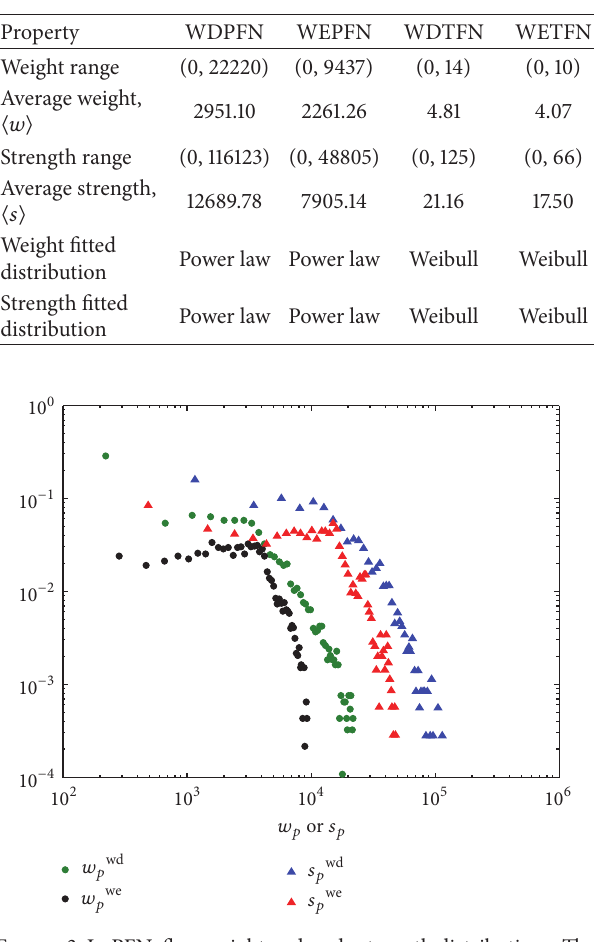
Figure 3: In PFN, flow weight and node strength distributions. The weights of passenger flow 𝑤 𝑝 wd and 𝑤 𝑝 we can be fitted by power law distributions with exponents 𝛾 = 0.96 and 𝛾 = 0.90 , respectively. The goodness-of-fit ( 𝑅 2 ) are all 0.99. And the strengths 𝑠 𝑝 wd and 𝑠 𝑝 we can be fitted by power law distributions with exponents 𝛾 = 0.73 and 𝛾 = 0.50 , respectively. The goodness-of-fit ( 𝑅 2 ) are 0.99 and 0.56.